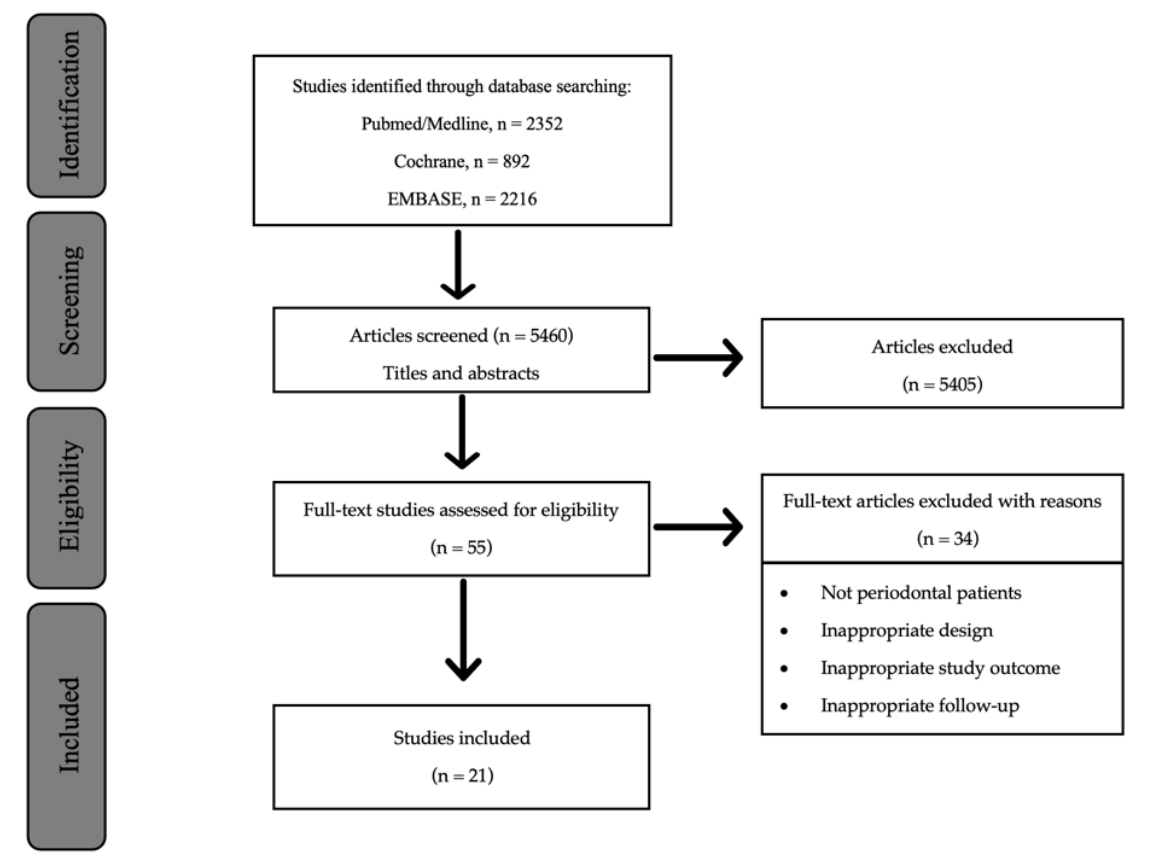
Figure 1. Flowchart showing PRISMA diagram for literature search and inclusion.